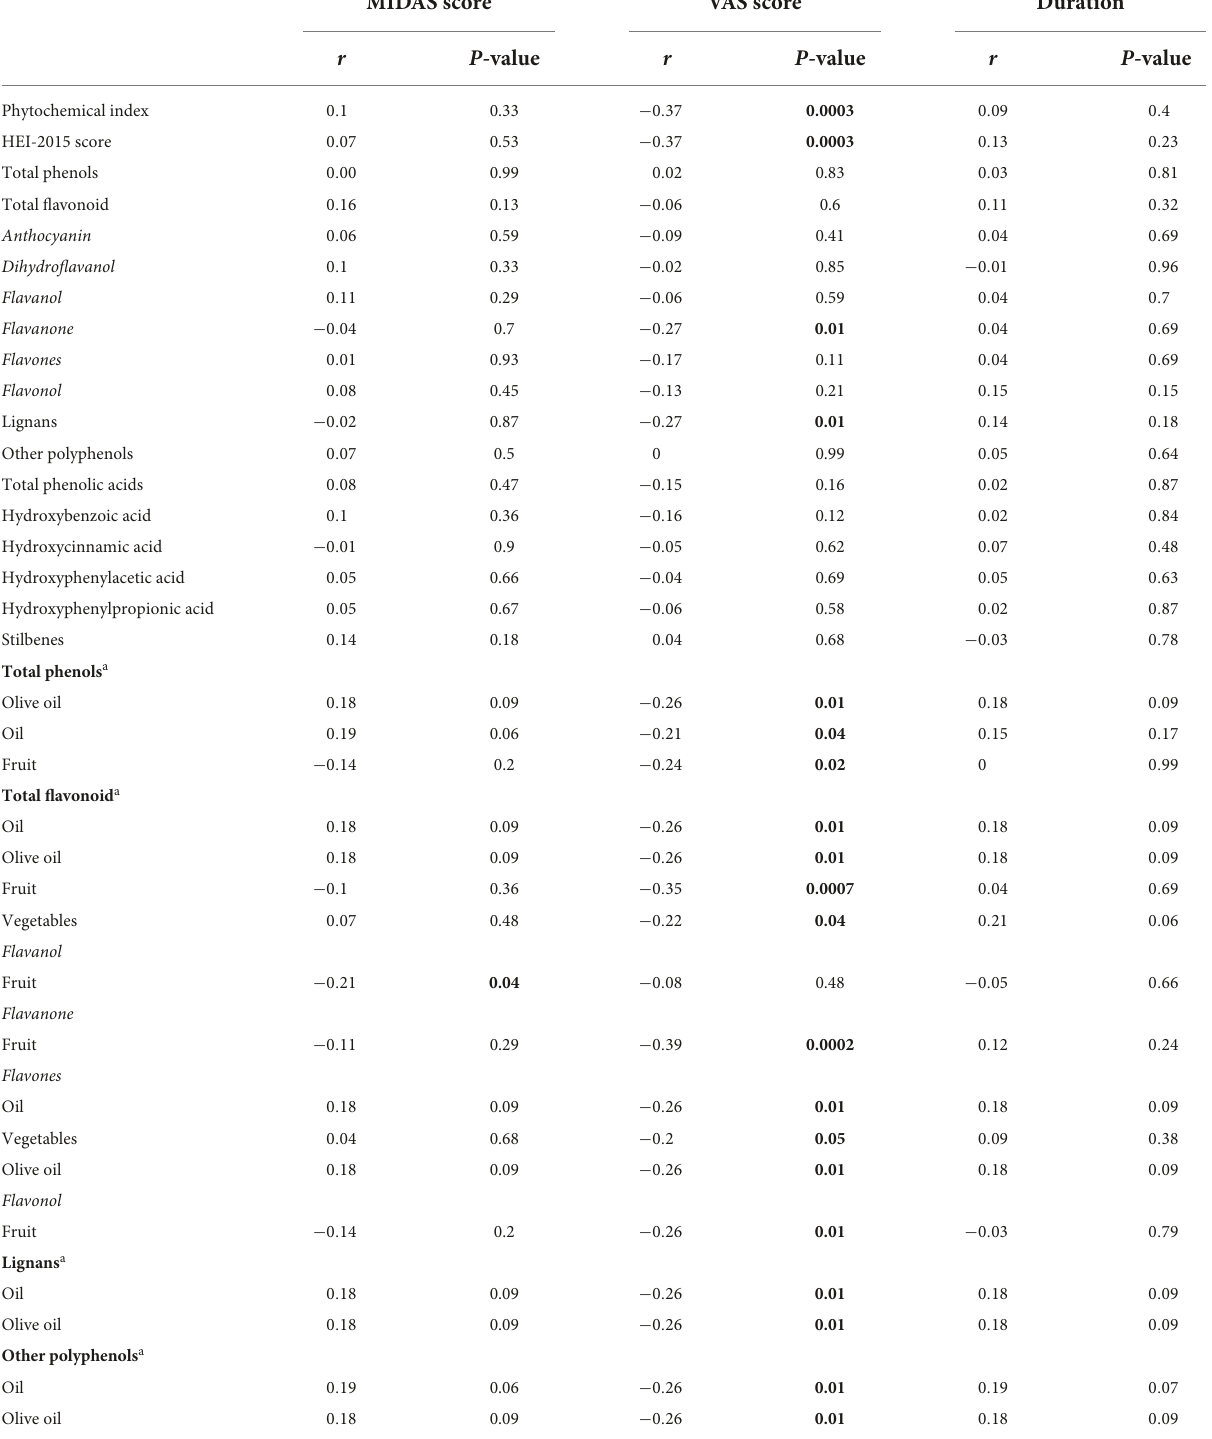
TABLE 4 Correlation of phytochemical and polyphenol intake and diet quality with migraine disability, severity, and duration. MIDAS score VAS score Duration r P